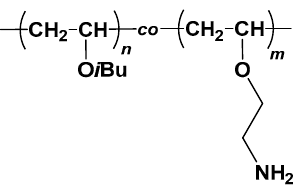
Figure 1. Chemical structure of poly(IBVE- co -AEVE)s.